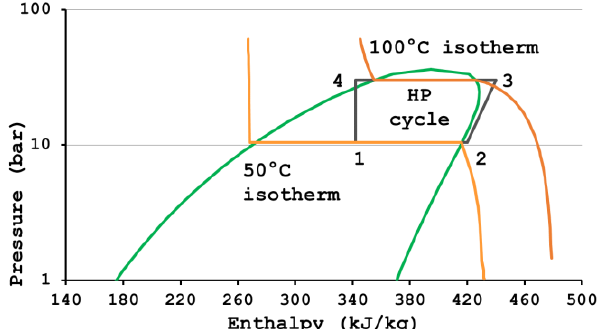
Figure 2. P-h diagram (green) and basic thermodynamic cycle (black) for refrigerant R-1234ze (E). There are shown the isotherms at 100 °C and 50 °C in orange color. 1 — Entrance to the evaporator, 2 — Entrance to the compressor, 3 — Entrance to the condenser, 4 — Inlet to the expansion valve.